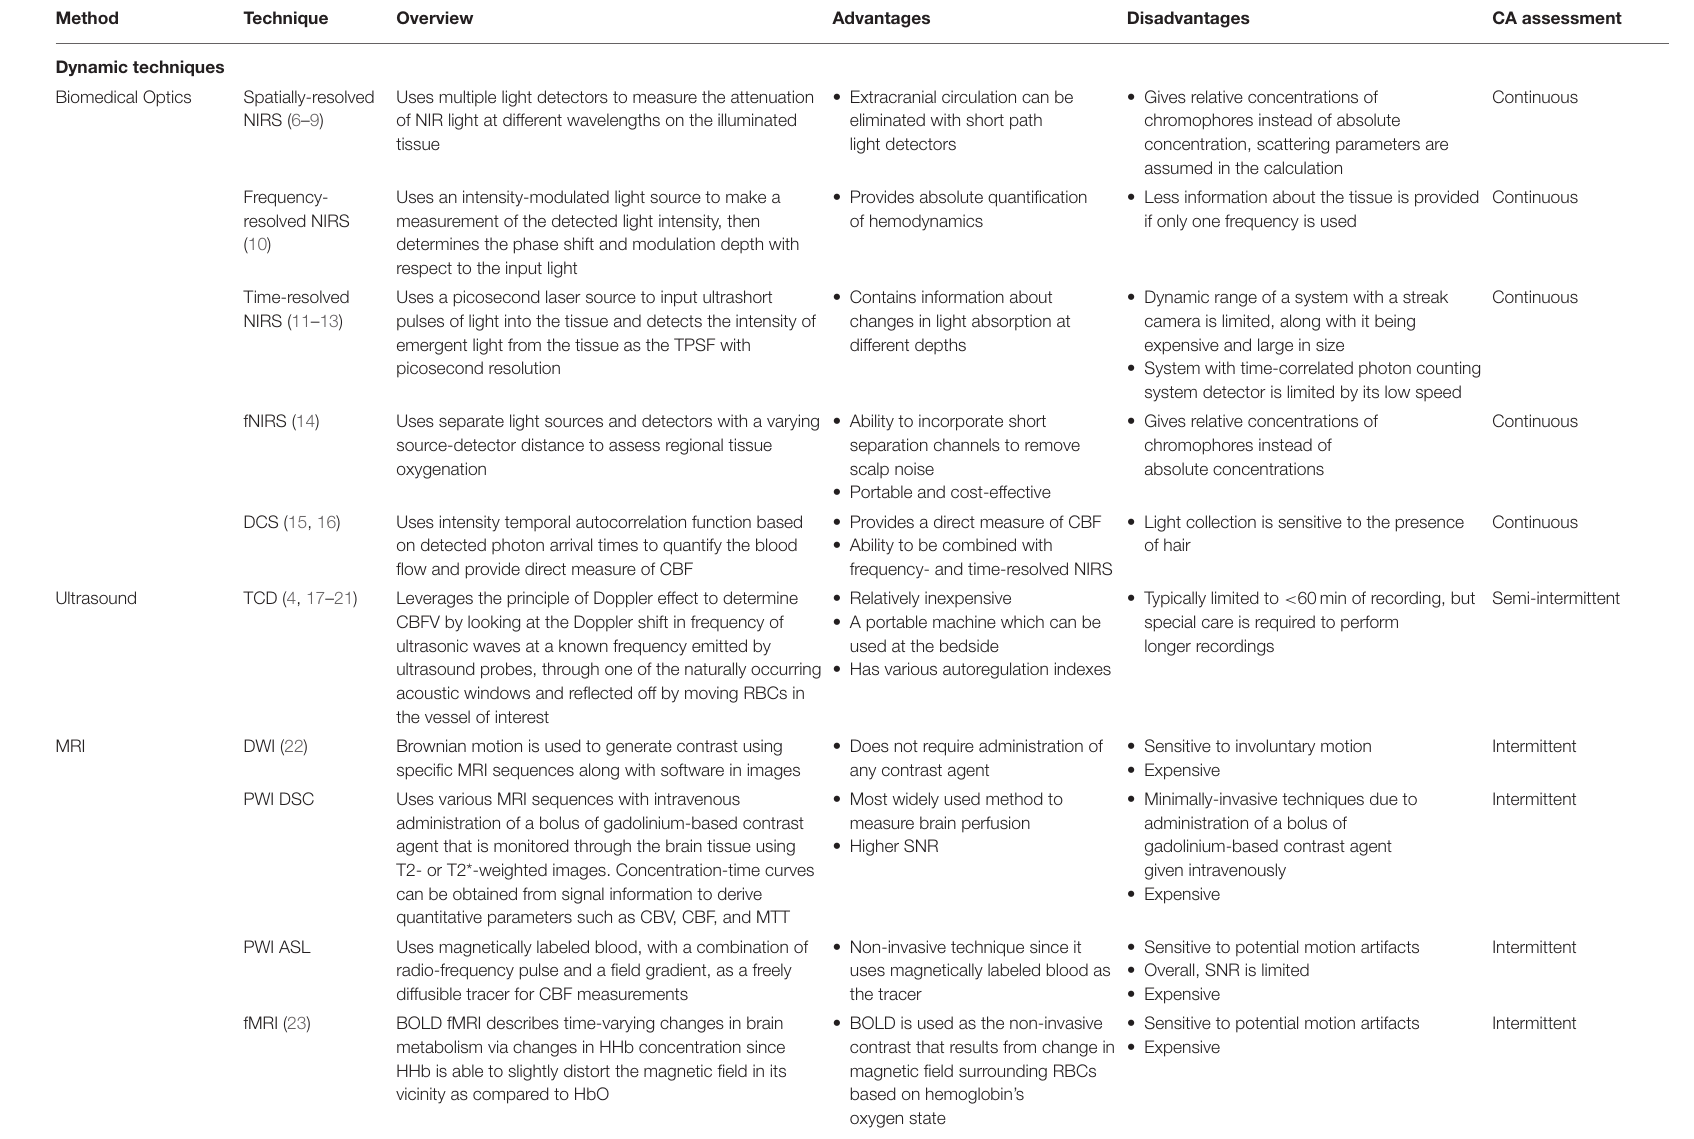
TABLE 1 | Non-/Minimally-invasive cerebral autoregulation techniques